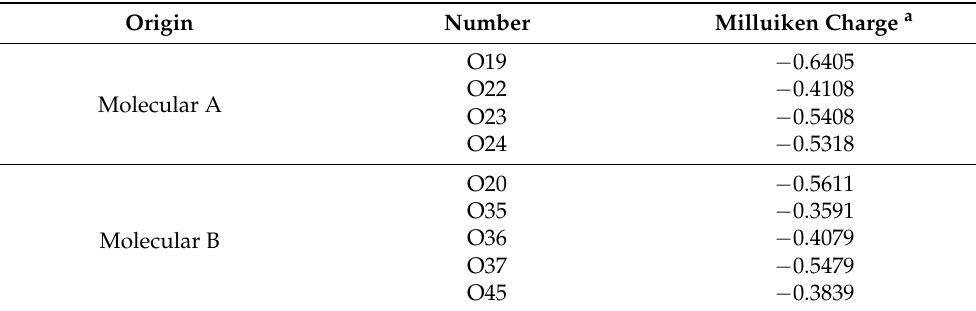
Table 3. The calculated Milluiken charge of the O atom from molecular A and B.